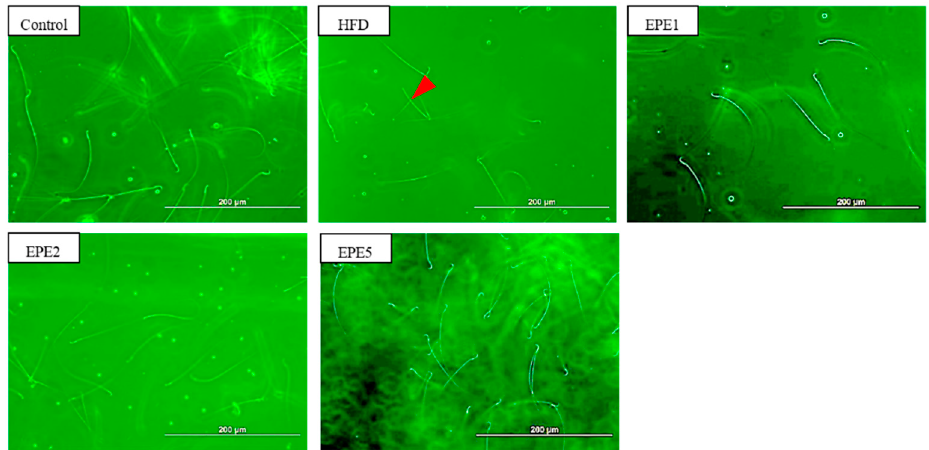
Figure 9. Effects of Echinacea purpurea ethanol extract on sperm morphology in HFD-induced obese rats after 5 weeks. Table 5. Effects of Echinacea purpurea ethanol extract on sperm parameters in HFD-induced obese rats after 5 weeks.